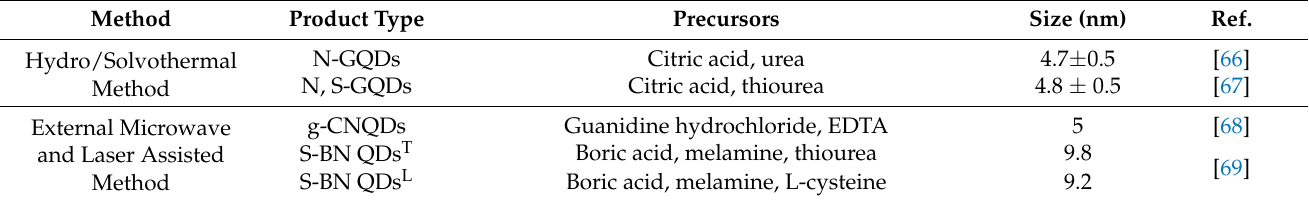
Table 2. Synthesis of 2D-QDs by bottom-up